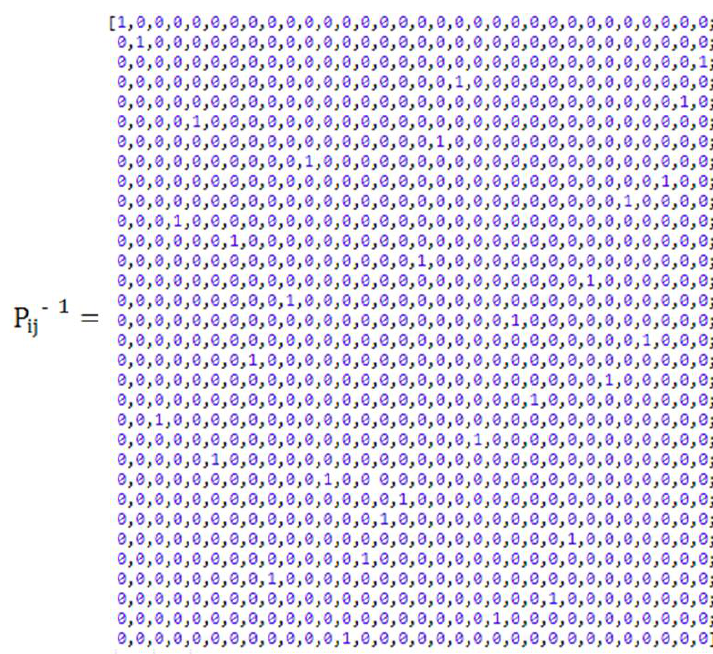
Figure A2. Inverse of 32 by 32 one-to-one permutation matrix.